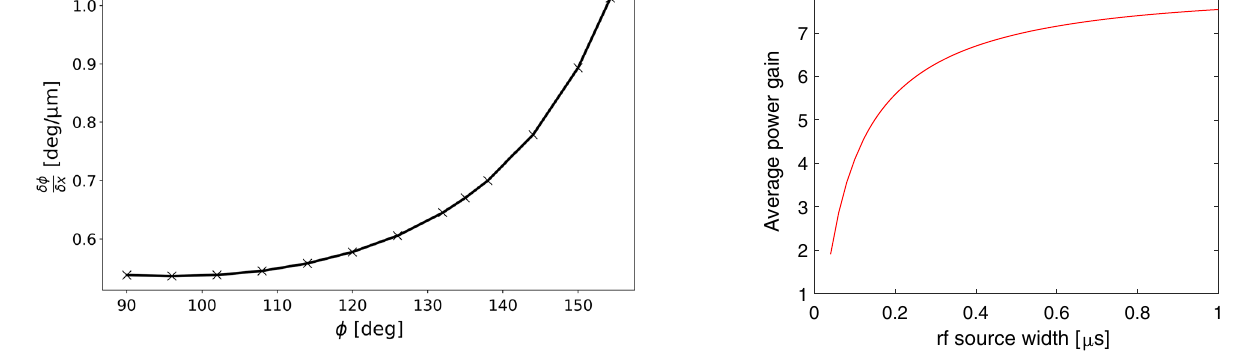
FIG. 9. Power factor gained by a 20 ns pulse coming out of the pulse compressor, as a function of rf power source pulse width.